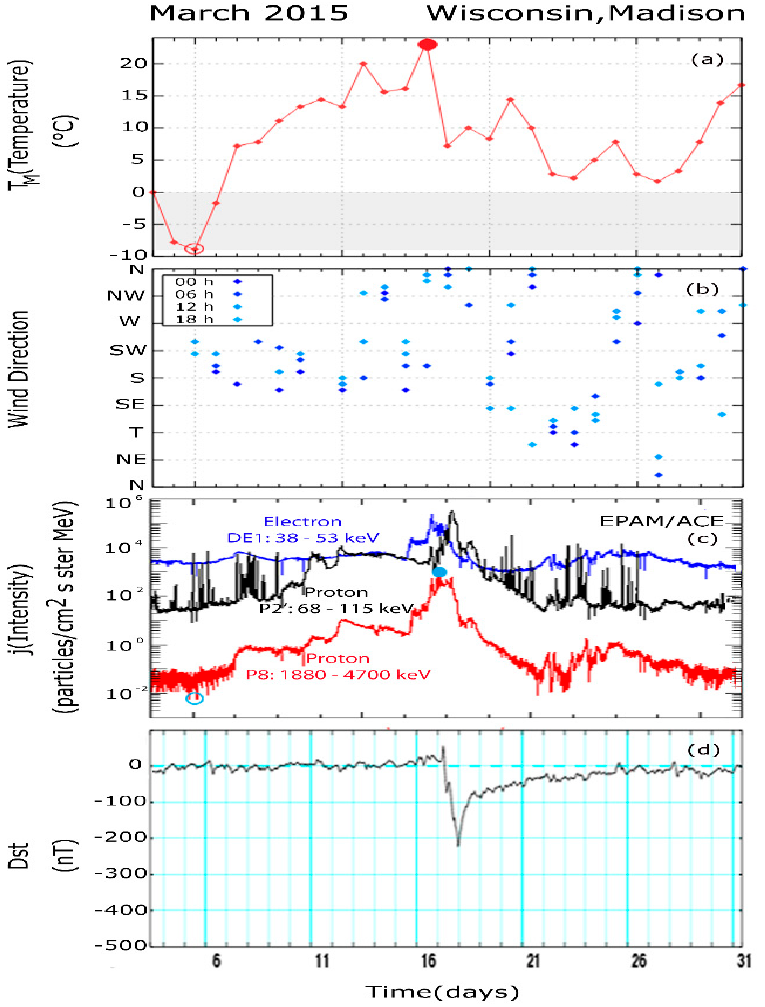
Figure 6. Time profiles of temperature in Madison, Wisconsin ( a ), the direction of wind in the same town ( b ), the fluxes of energetic protons and electrons observed by the ACE spacecraft and ( d ) the values of the geomagnetic index Dst, during 3–31 March 2015. It is evident that the temperature profile ( a ) resembles that of the high-energy solar proton flux P8 (( c ); red curves). The great temperature increase from − 9 to 23 °C was recorded during an SEP event (6–16 March 2015) under a general south wind streaming ( b ).